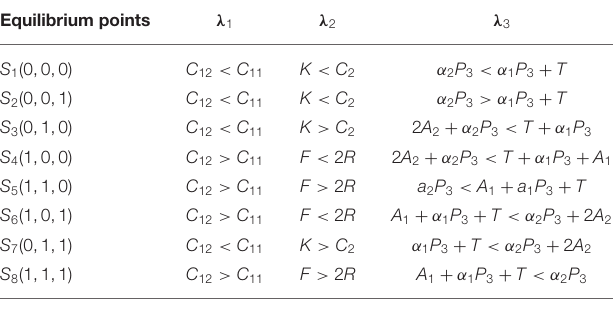
TABLE 4 | Equilibrium points stability